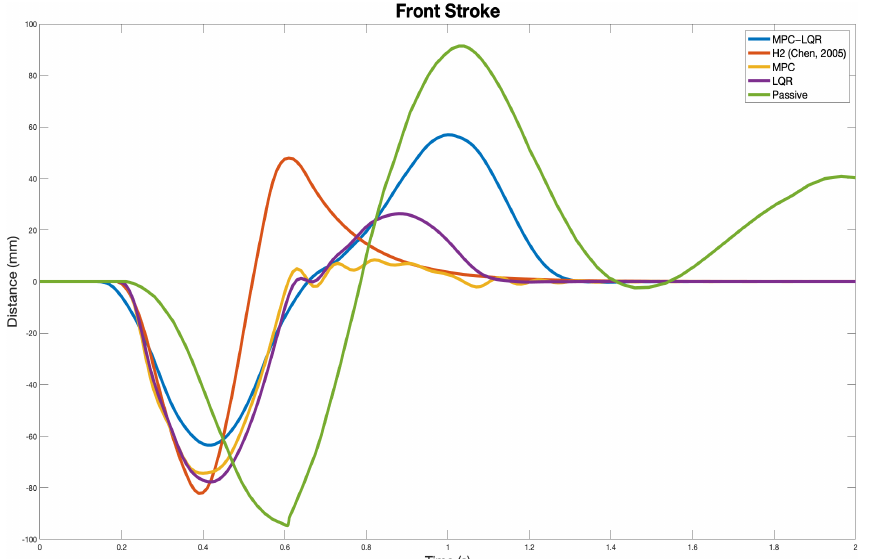
Figure 8. Front Stroke (Blue—MPC-LQR, Red—H2, Yellow—MPC, Purple—LQR, Green—Passive).